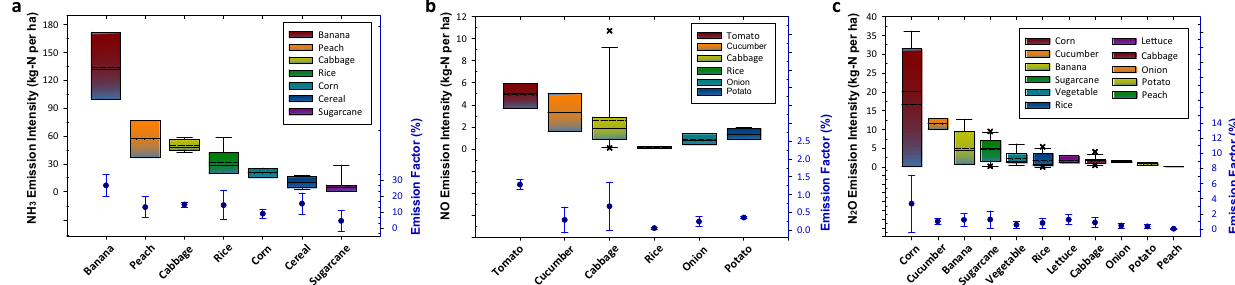
Fig. 3 Effect of different crops on emission intensity and factor for nitrogenous gases. a NH 3 emission for different crops, and the detailed data are compiled in Supplementary Table 3; b NO emission for different crops, and the detailed data are compiled in Supplementary Table 4; c N 2 O emission for different crops, and the detailed data are compiled in Supplementary Table 5. All error bars are determined at the 0.05 con fi dence level (Student ’ s t